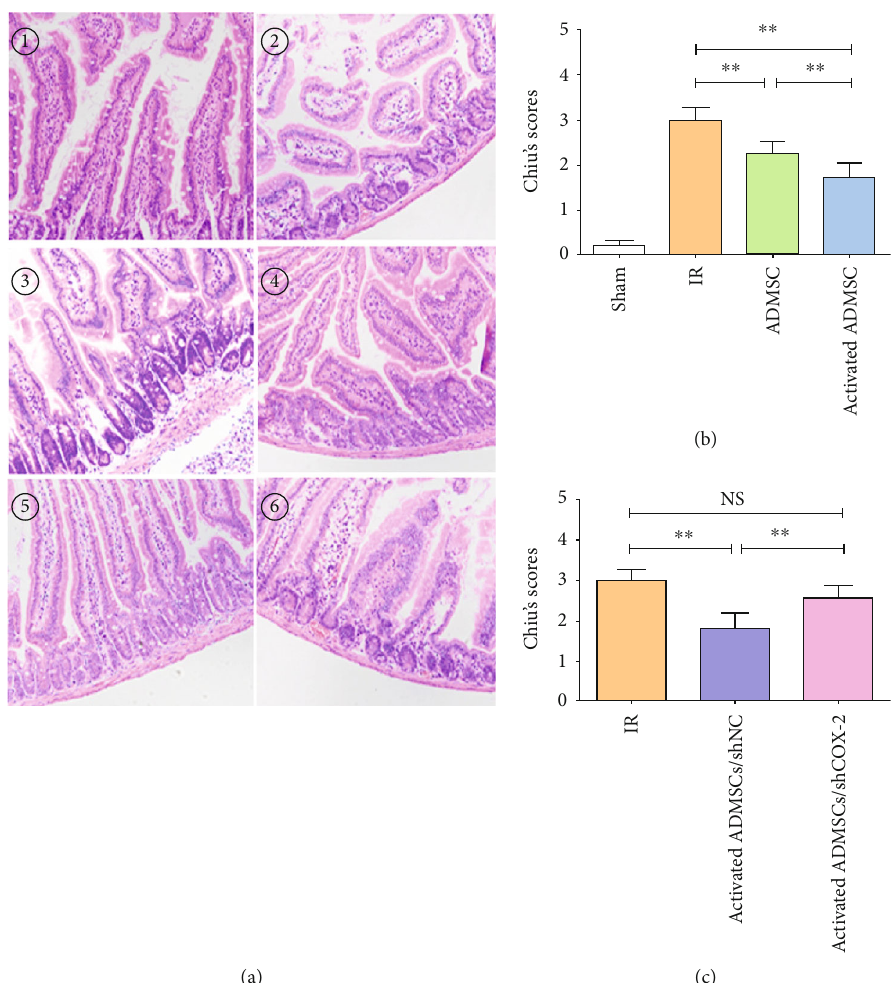
Figure 3: Activated ADMSC enhanced healing of intestinal IR injury dependent on COX-2-PGE and eosin staining (HE) pictures for di ff erent groups ( ① sham, ② IR, ③ ADMSCs, ④ activated ADMSC, and ⑤ activated ADMSC/shNC or ⑥ activated ADMSC/shCOX-2). (b, c) Chiu ’ s scores for assessment of intestinal IR injury after di ff erent treatments ( ∗∗ P < 0 : 01 , NS: no statistical signi fi cance, Bonferroni ’ s multiple